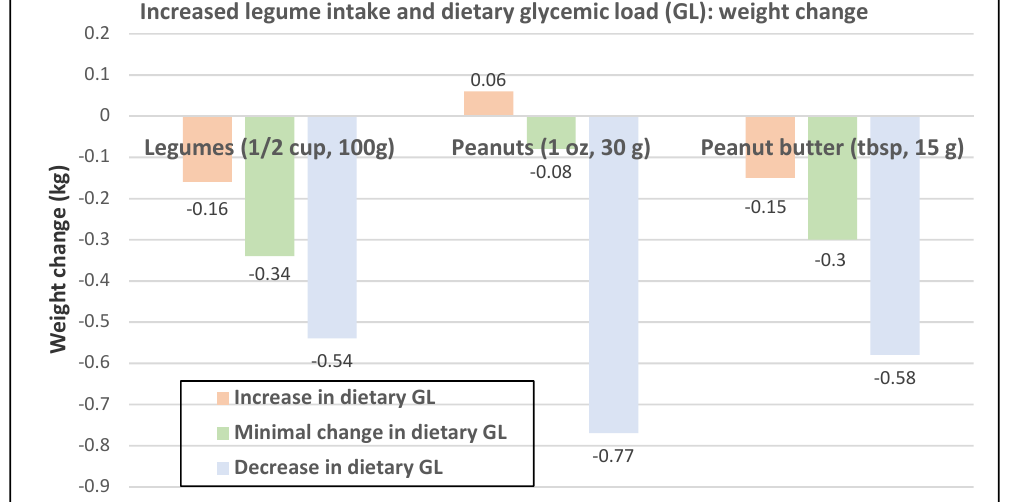
Figure 26. Multivariate adjusted association between increased protein-rich legume vegetable intake per serving/day and dietary glycemic load (GL) status and effect on weight change for all Nurses’ Health Studies (NHS, NHS II), and Health Professionals Follow-up Study (120,784; 80% women) per 4-year period (decreasing GL p < 0.01) [19].